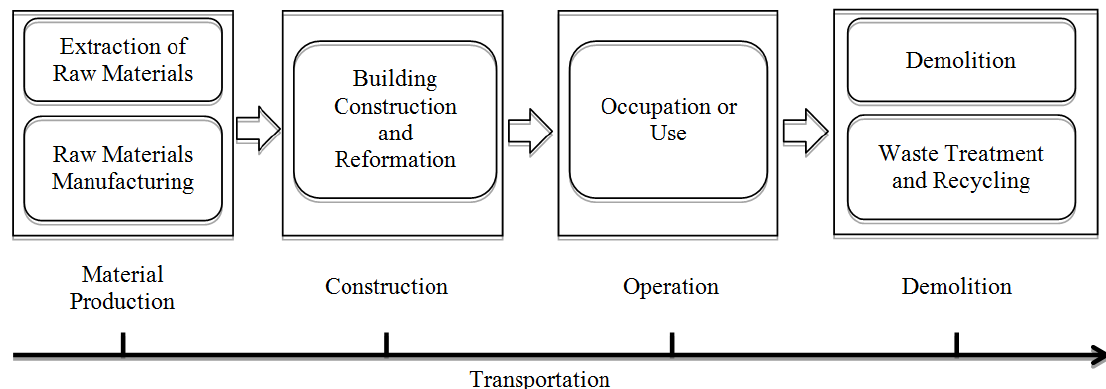
Figure 1. The life cycle phases of a